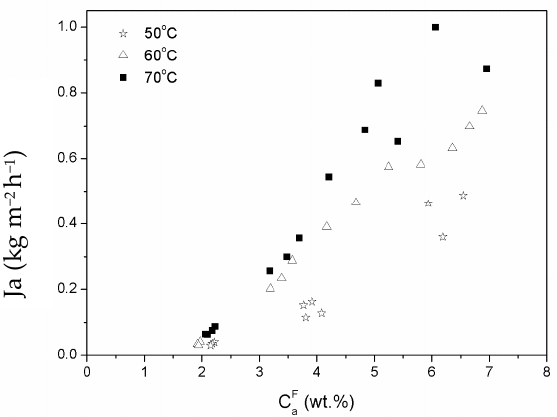
Figure 3. Water permeate flux for different temperatures and concentrations.